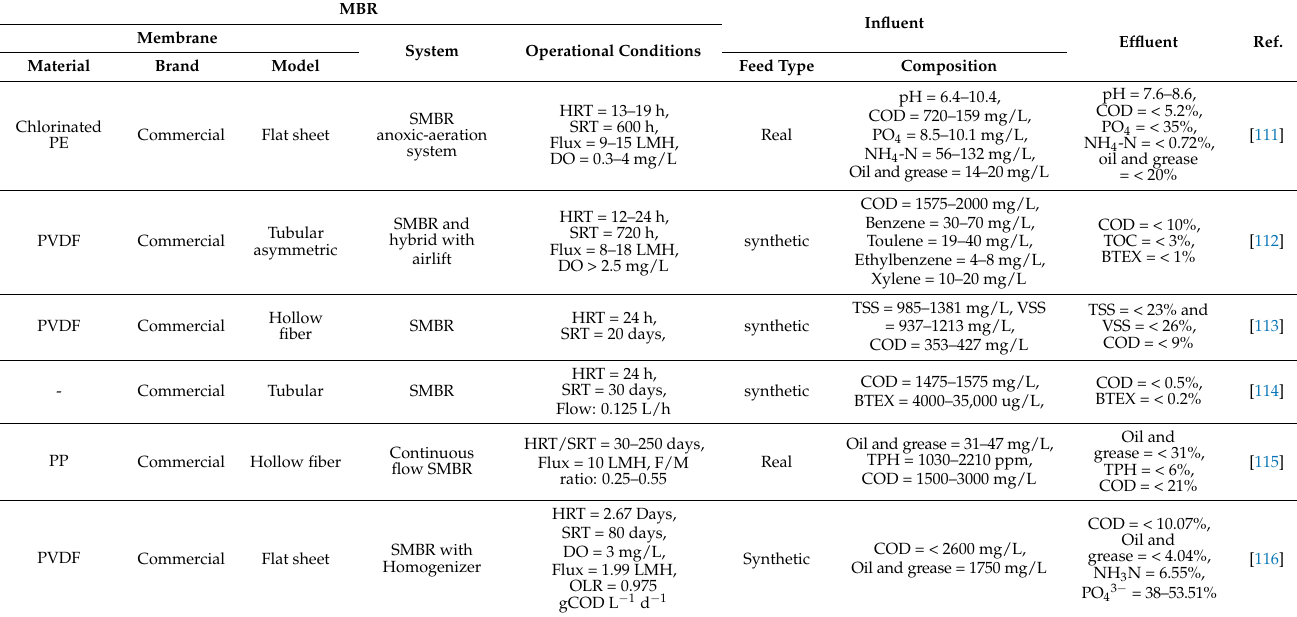
Figure 5. Treatment mechanism of an MBR. Table 3. Performance of MBR in produced water